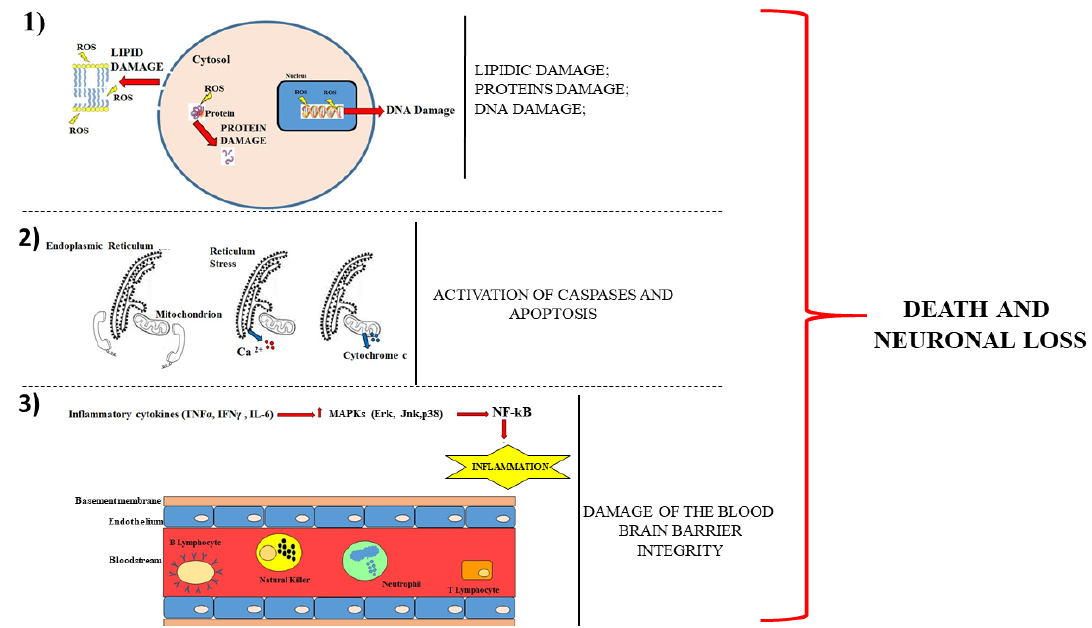
Figure 1. Description of the main mechanisms involved in neuronal damage. The panel ( 1 ) shows that the cell death occurs following the damage to proteins, lipids and DNA. Panel ( 2 ) describes how the loss of communication between the endoplasmic reticulum and the mitochondrion leads to the leakage of calcium ion from the reticulum and of cytochrome c from the mitochondrion. The consequences are caspases activation and apoptotic cell death. Panel ( 3 ) shows a section of the blood–brain barrier with the endothelium surrounding the bloodstream. The production of cytokines determines the activation of mitogen-activated protein kinases (MAPKs), which increase the immune cells in the blood. The breaking of the integrity of the barrier favours the infiltration of these cells encouraging neurodegeneration.